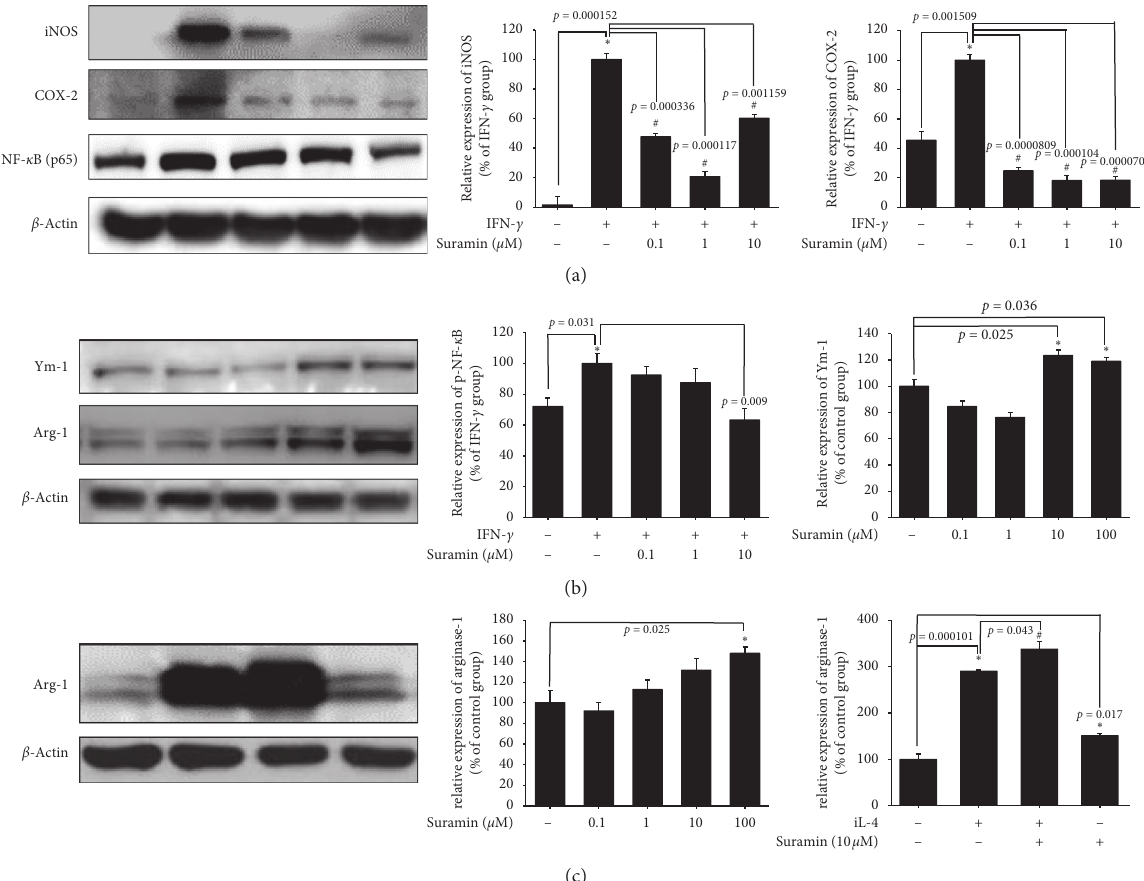
Figure 1: Effect of suramin on interferon-gamma- (IFN- c - ) induced upregulation of iNOS (inducible nitric oxide synthase) and COX-2 (cyclooxygenase-2) and increased Ym-1 and arginase-1 (arg-1) in BV2 murine microglial cells. (a) BV2 cells were cotreated with 0.1, 1, or 10 μ M suramin and challenged with 10U/mL of IFN- c for 24 h; western blotting for iNOS, COX-2, and NF- κ B (p65) of the control; IFN- c ; and IFN- cc plus 0.1, 1, or 10 μ M suramin group is shown. β -Actin was used as an internal control. Data are presented as mean ± SEM, and each value contains three replicates and three samples. ∗ Significantly different from the control group; # significantly different from the IFN- c group. (b) BV2 cells were treated with 0.1, 1, 10, and 100 μ M suramin for 24h; western blotting for Ym-1 and arg-1 proteins of the control, 0.1, 1, 10, or 100 μ M suramin group is shown. β -Actin was used as an internal control. Data are presented as mean ± SEM, and each value contains three replicates and three samples. ∗ Significantly different from the control group. (c) BV2 cells were cotreated with 10 μ M suramin and challenged with IL-4 for 24h; western blotting for the arg-1 protein of the control; IL-4; and IL-4 plus 0.1, 1, 10, or 100 μ M suramin group is shown. β -Actin is used as an internal control. Data are presented as mean ± SEM, and each value contains three replicates and three samples. ∗ Significantly different from the control group; # significantly different from the IL-4